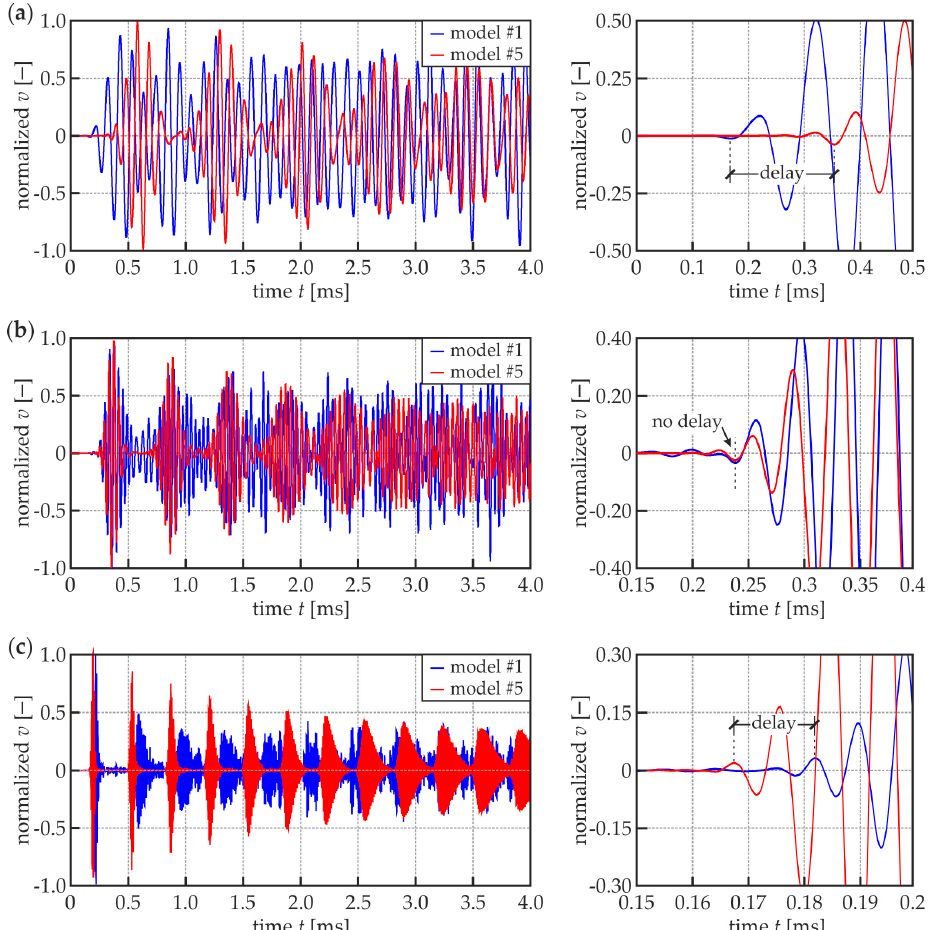
Figure 6. Normalized velocity signals (whole signals and zoom) registered at point R5 in numerical models of specimens #1 and #5 for different excitation frequencies: ( a ) 10 kHz; ( b ) 23 kHz; and ( c ) 100 kHz. Table 2. Time of flight of the wave packet based on the dispersion curves and the wave signals. Frequency f